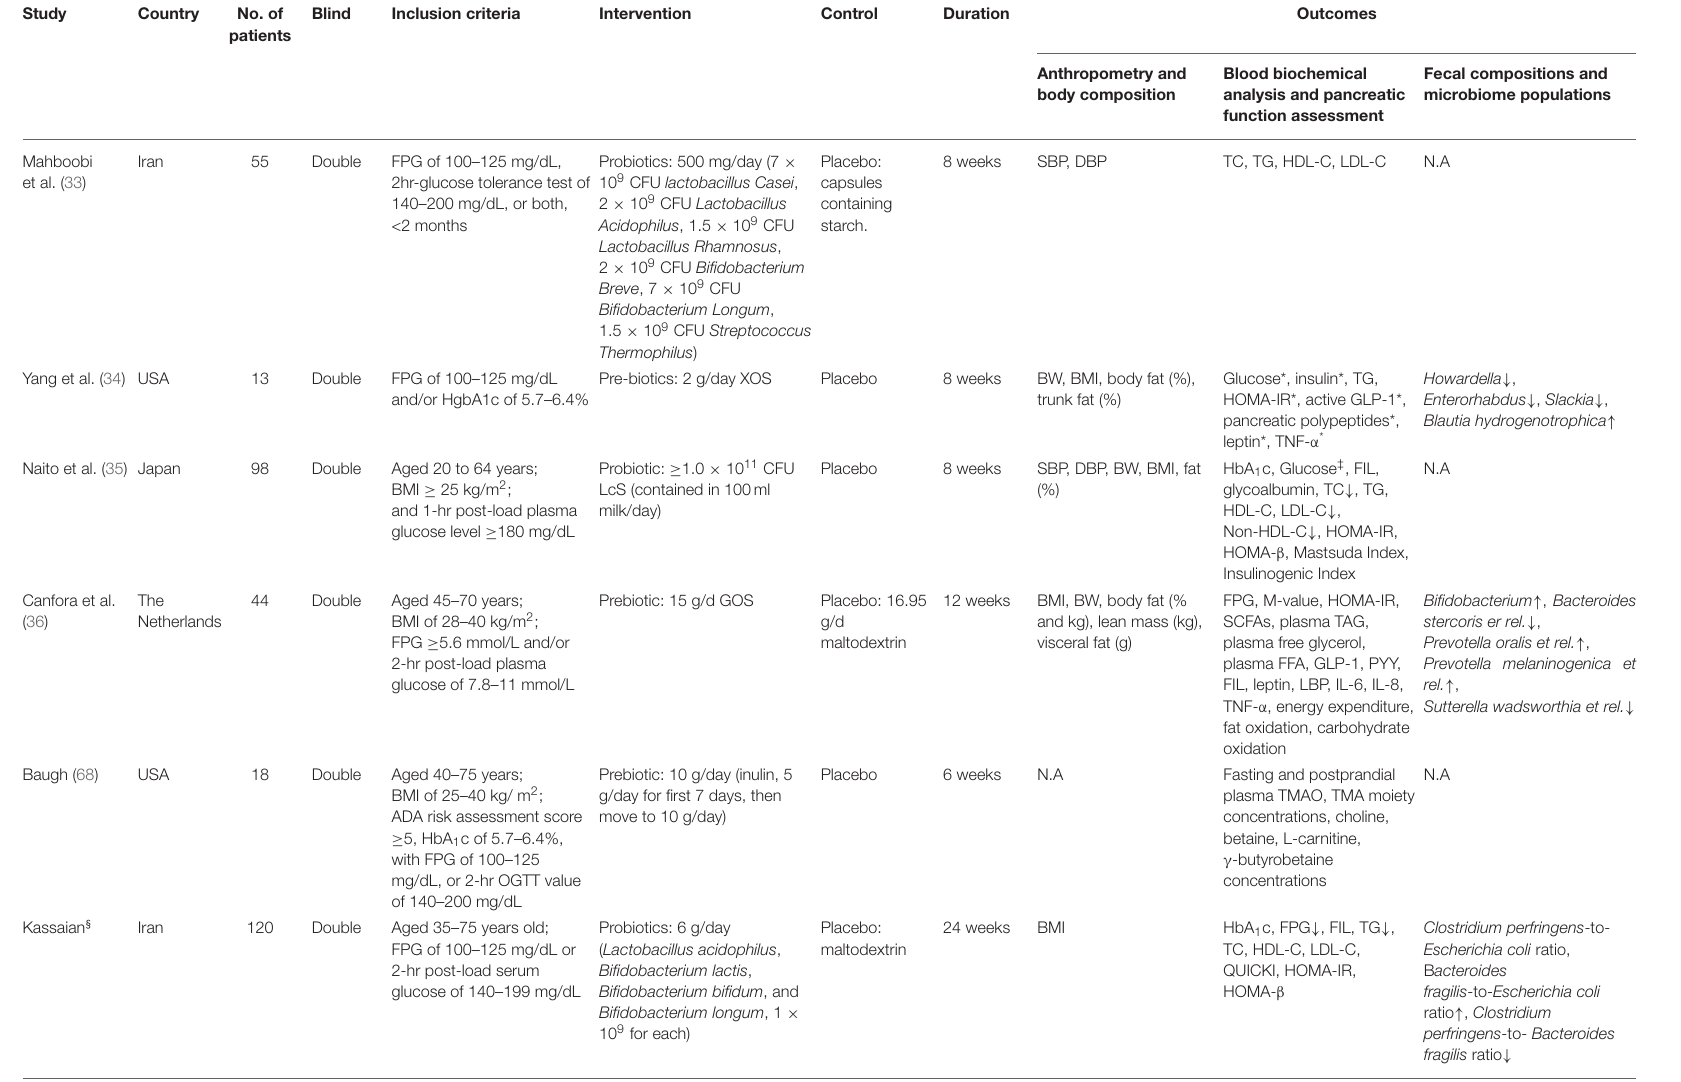
TABLE 1 | Human clinical trials of probiotics, pre-biotics, and synbiotics for the treatment of pre-diabetes. Study Country No. of Blind Inclusion patients